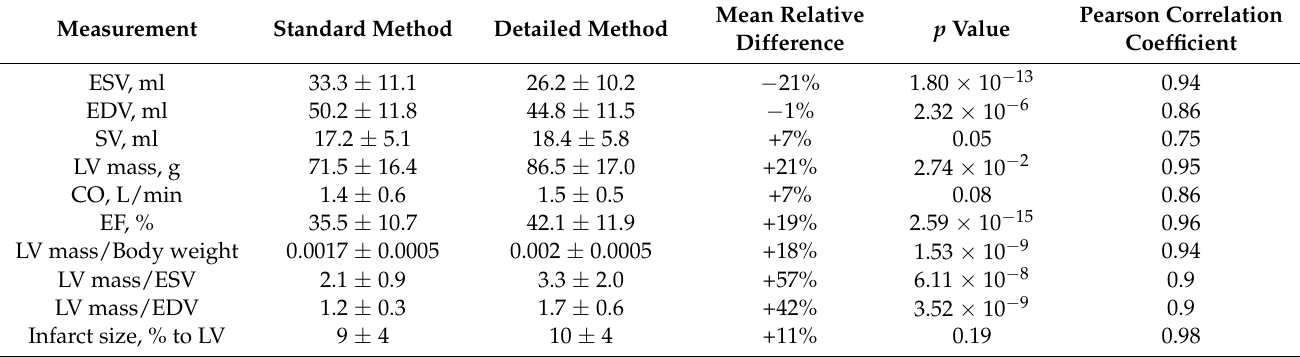
Table 2. Comparison of the volumetric measurements of the infarcted hearts of Yucatan minipigs using the standard method and the detailed method ( n =